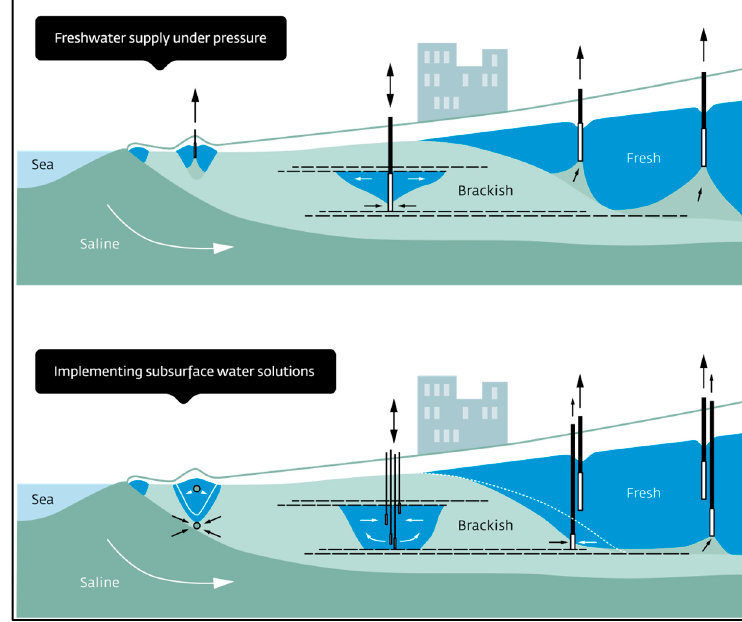
Figure 2 . Advanced freshwater management in coastal zones through SWS: